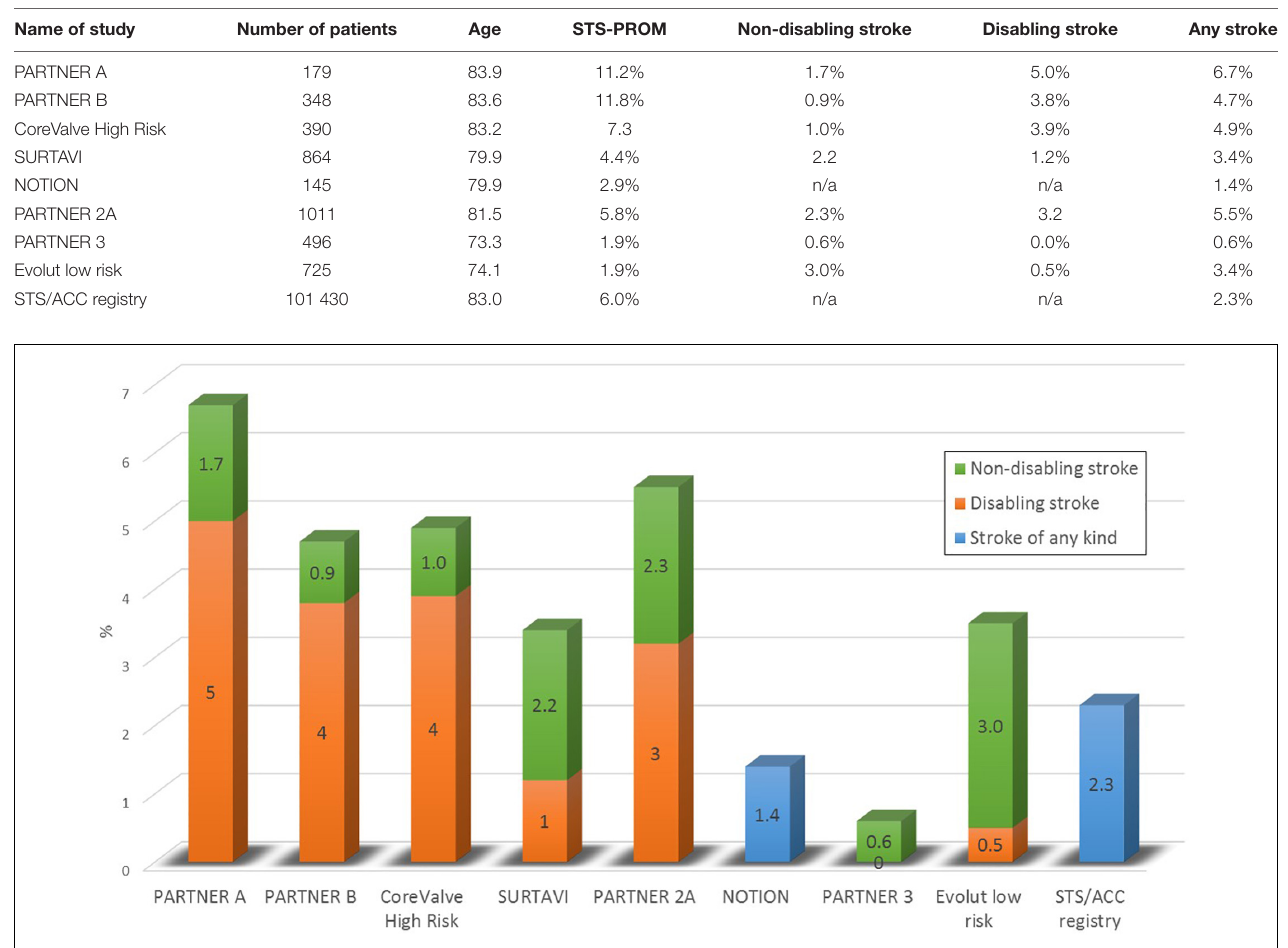
FIGURE 1 | The incidence of stroke within 30 days after TAVI in randomized controlled trials and in a real world clinical registry.